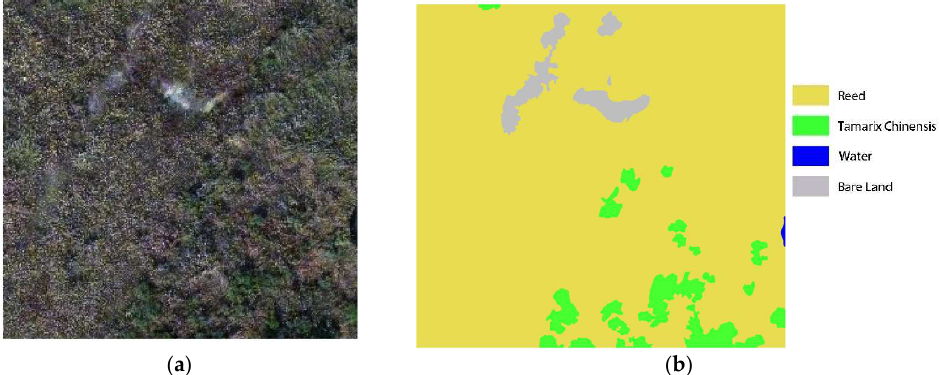
Figure 8. ( a ) The true color image of wetland; ( b ) the map of feature distribution in the study area. In Figure 9, the extraction results of VCA, EBE, SSEBE, AAEBE, and the proposed method are shown from top to bottom. As in the simulated hyperspectral data experi- ment, the abundance estimation was performed by FCLS with endmembers extracted us- ing the five methods, and the abundance maps are presented in Figure 10. Table 2 indi- cates the comparison results between MSREBE and the other